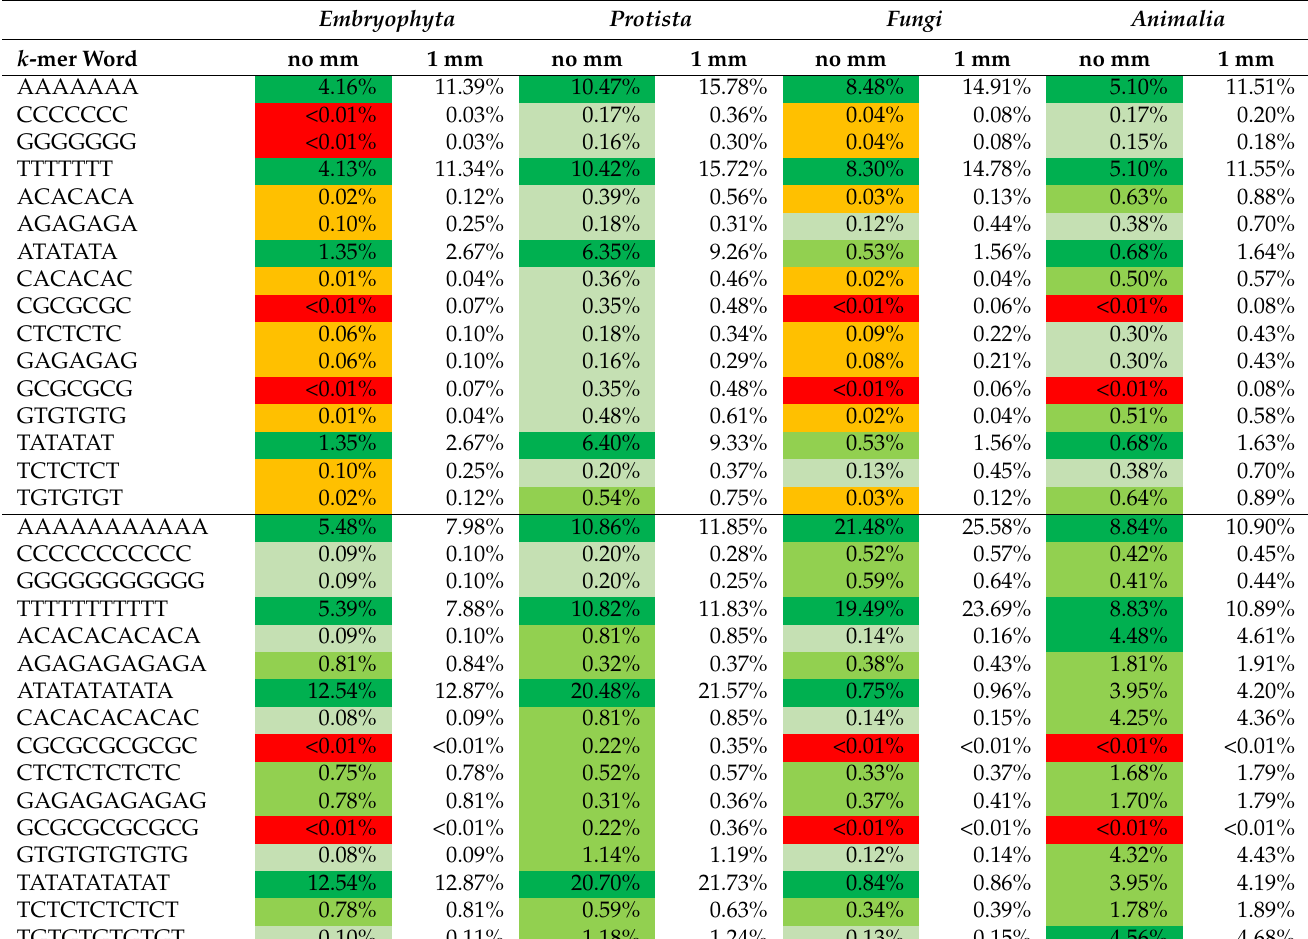
Table 4. The correlation contributions for correlations between introns and intergenic regions for tandem repeat k -mer words with repeat unit length ≤ 2bp for no and up to one allowed mismatch